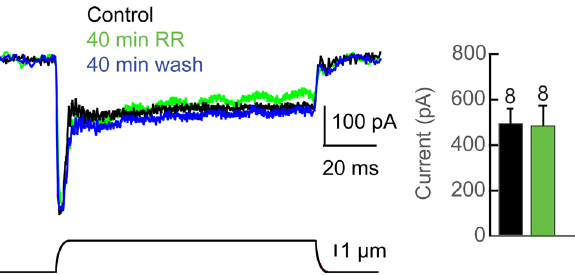
Figure 6. Ruthenium Red (RR) effect on mechanotransduction current. Step mechanical stimulus under voltage clamp induced inward current in a VS-3 neuron that was superfused in spider saline with 1 µM TTX ( black trace ). When 10 µM Ruthenium Red was added to the bath solution, the current remained unchanged ( green trace ) and similar current was also recorded after 40 min wash ( blue trace ). Bar graph shows the peak currents from 8 similar experiments under control conditions and 40 min after Ruthenium Red was added to the bath solution. There was no statistically significant difference between the MET currents (one tailed paired t-test p = 0.42735).